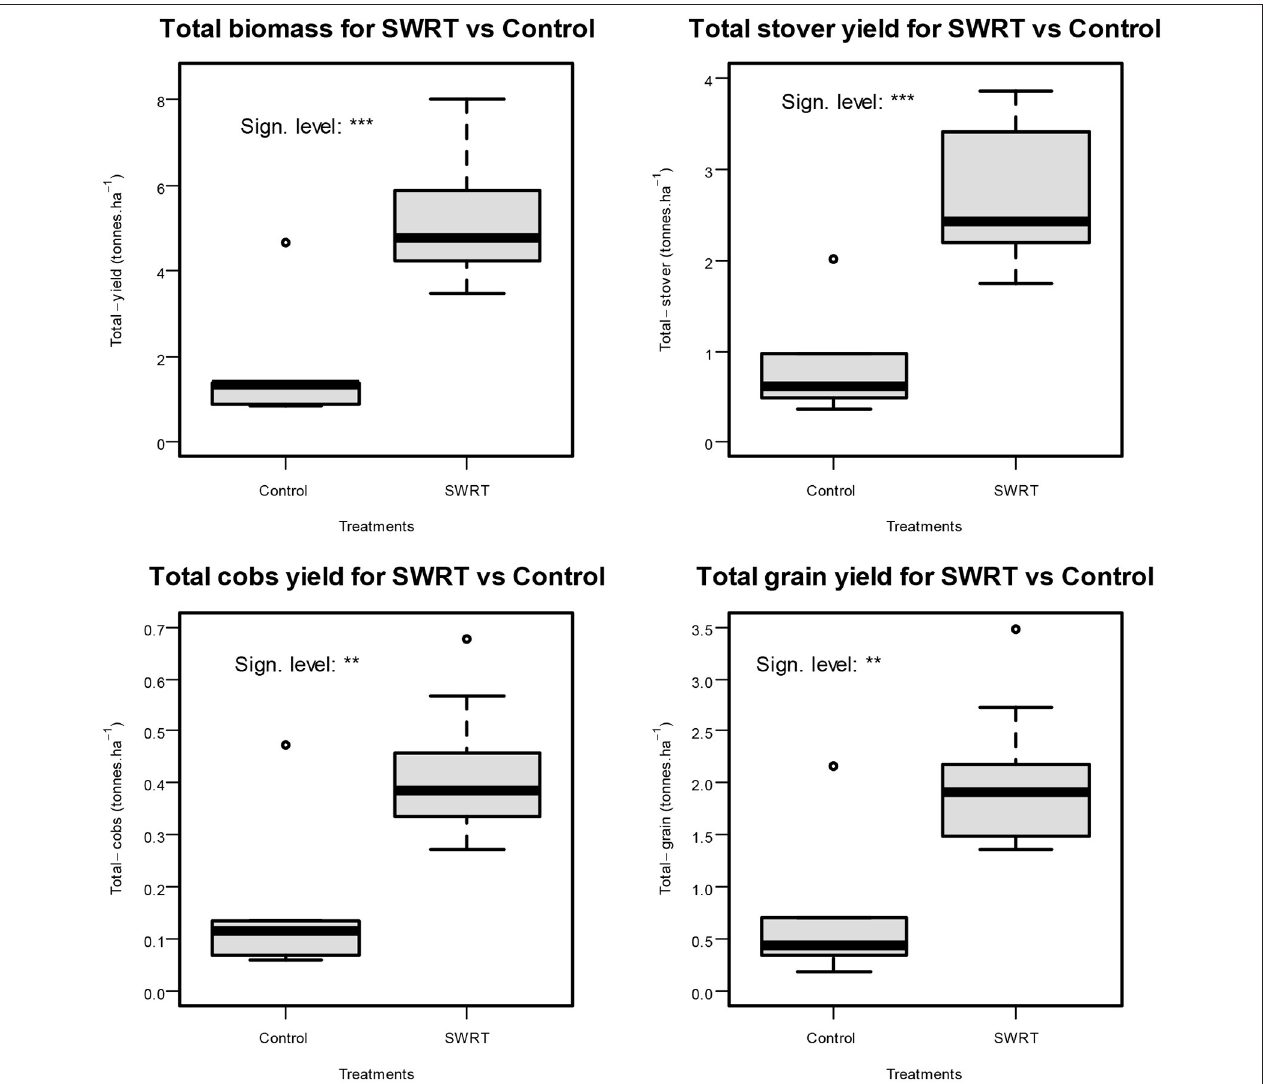
FIGURE 6 | Yield at harvest in sub-surface water retention technology (SWRT) plots and control plots of total maize biomass (sum of stover, cobs, and grain) and of maize stover, cobs, and grain. “Sign. level” in each panel denotes the significance level of differences between SWRT and control plots (*** p < 0.001, ** p < 0.01).